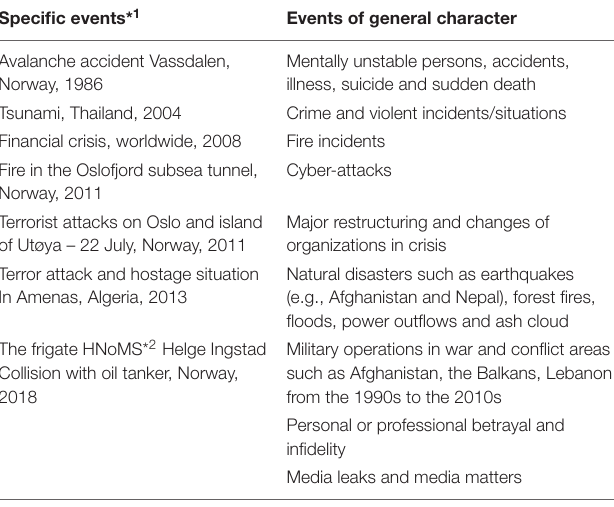
TABLE 2 | Examples of unforeseen events experienced by the study